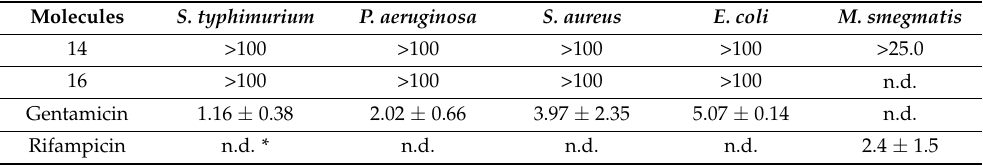
Table 3. Spectrum activity of hydrazones against gram-positive and negative bacteria and Mycobac- terium smegmatis . Results as a medium ± standard deviation in μ g/mL.